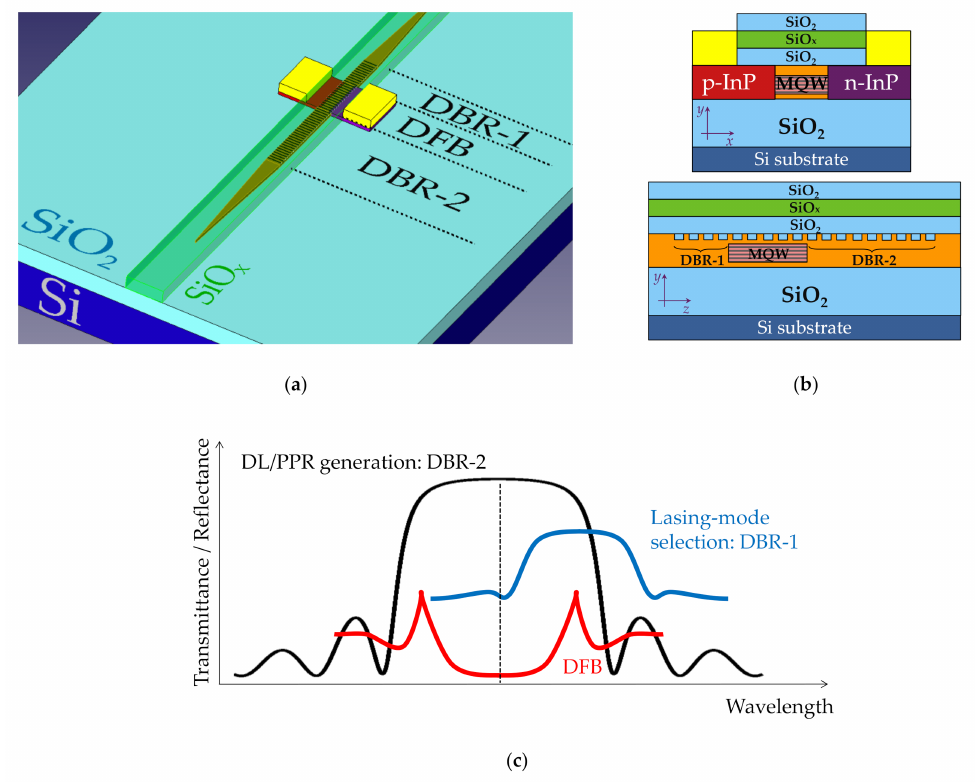
Figure 1. Device schematic: ( a ) Bird’s eye view of the distributed reflector (DR) laser structure. The overcladding SiO 2 layer is omitted for visibility; ( b ) Cross-sectional view: x - y plane of distributed feedback (DFB) section (top) and y - z plane of entire laser (bottom). The grating was formed on the InP surface; ( c ) Lasing-mode selection (based on distributed Bragg reflector (DBR)-1) and detuned- loading (DL)+ photon–photon resonance (PPR) generation (based on DBR-2)